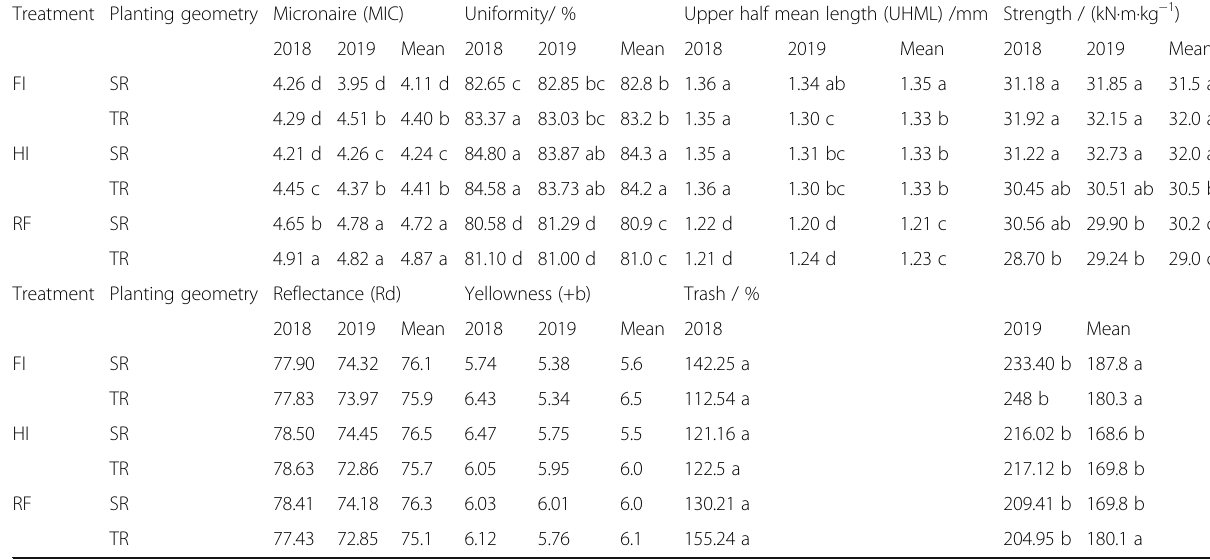
Table 2 Fiber quality characteristics of irrigation treatments (FI, HI, and RF) on cotton in a Dundee silt loam with single-row (SR) and twin-row (TR) planting geometries estimated by high volume instrument (HVI). FI is full irrigation; HI is half irrigation; RF is rain-fed Treatment Planting geometry Micronaire